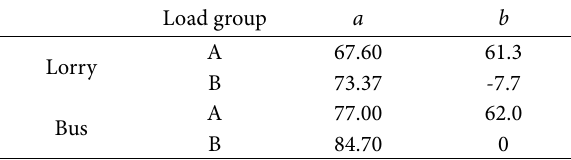
Table 7. Values of constants a and b according Procedure 2001-52